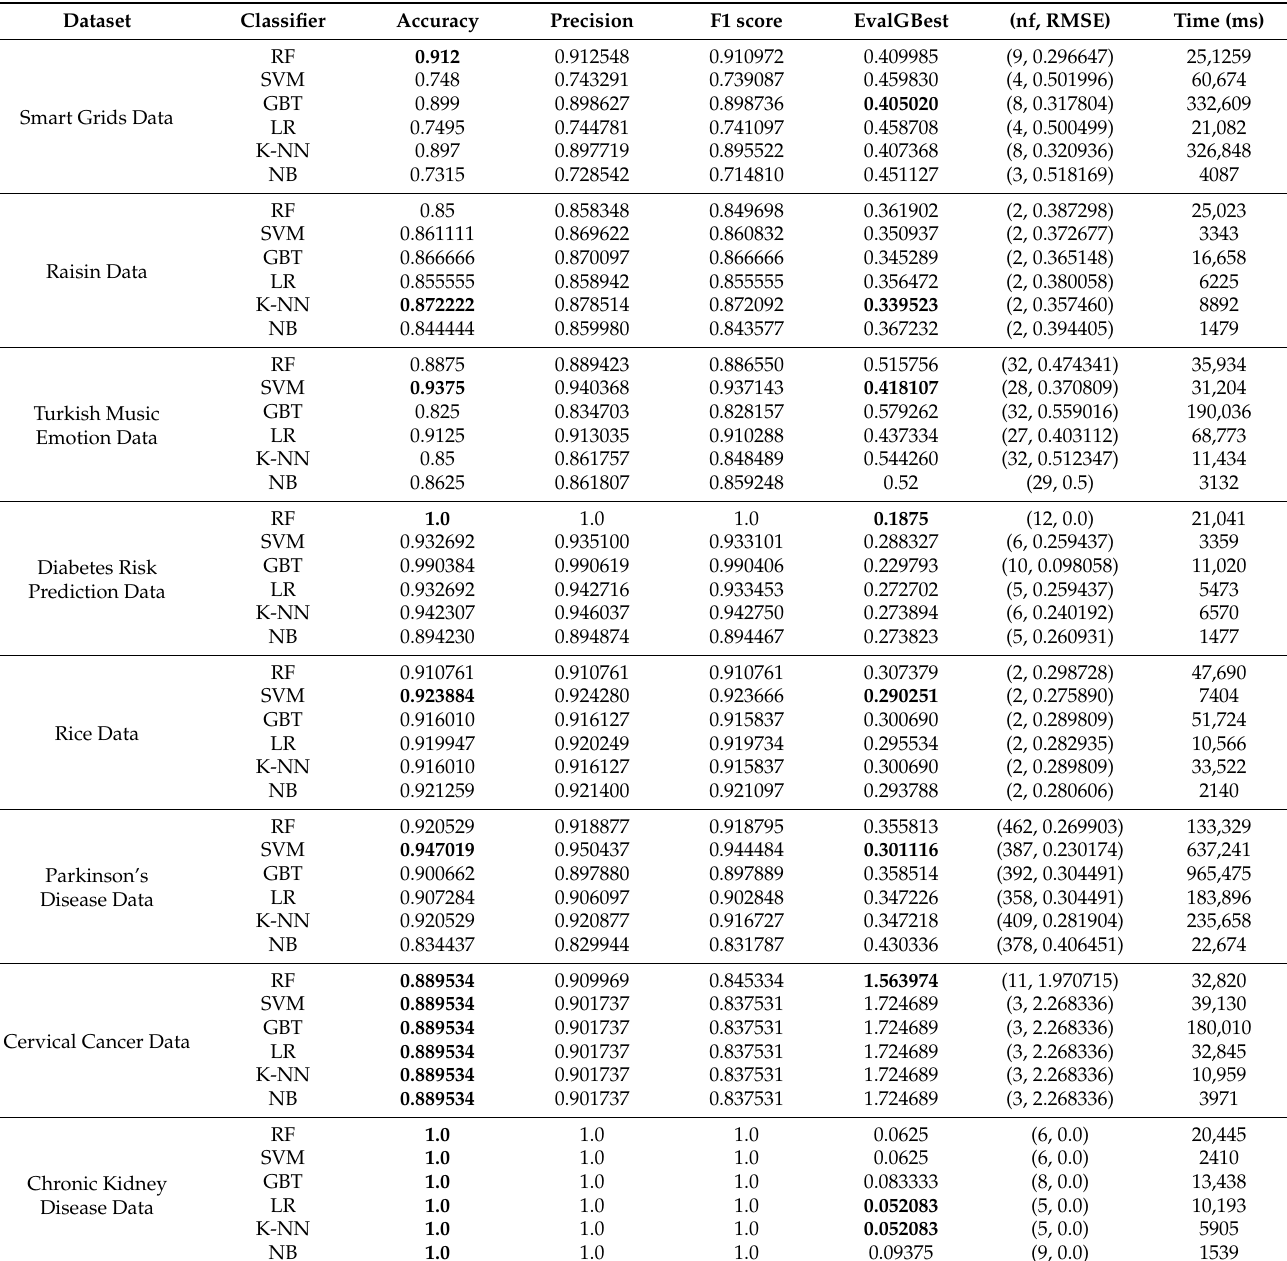
Table 9. BGWO Experimental Results